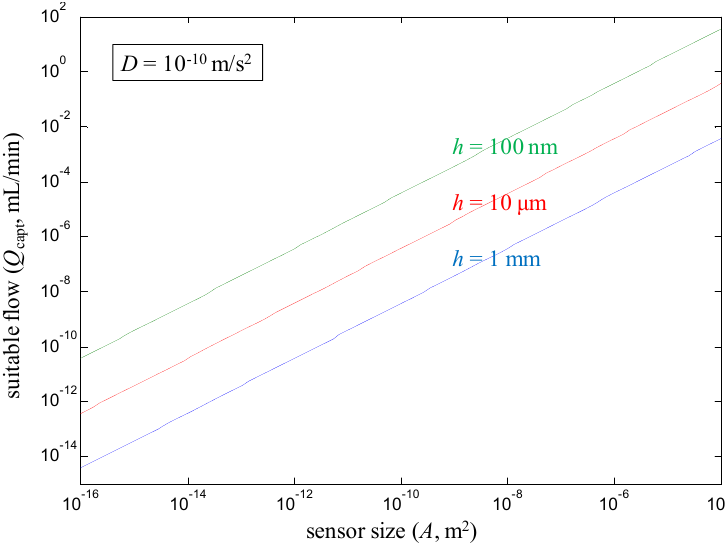
will still capt